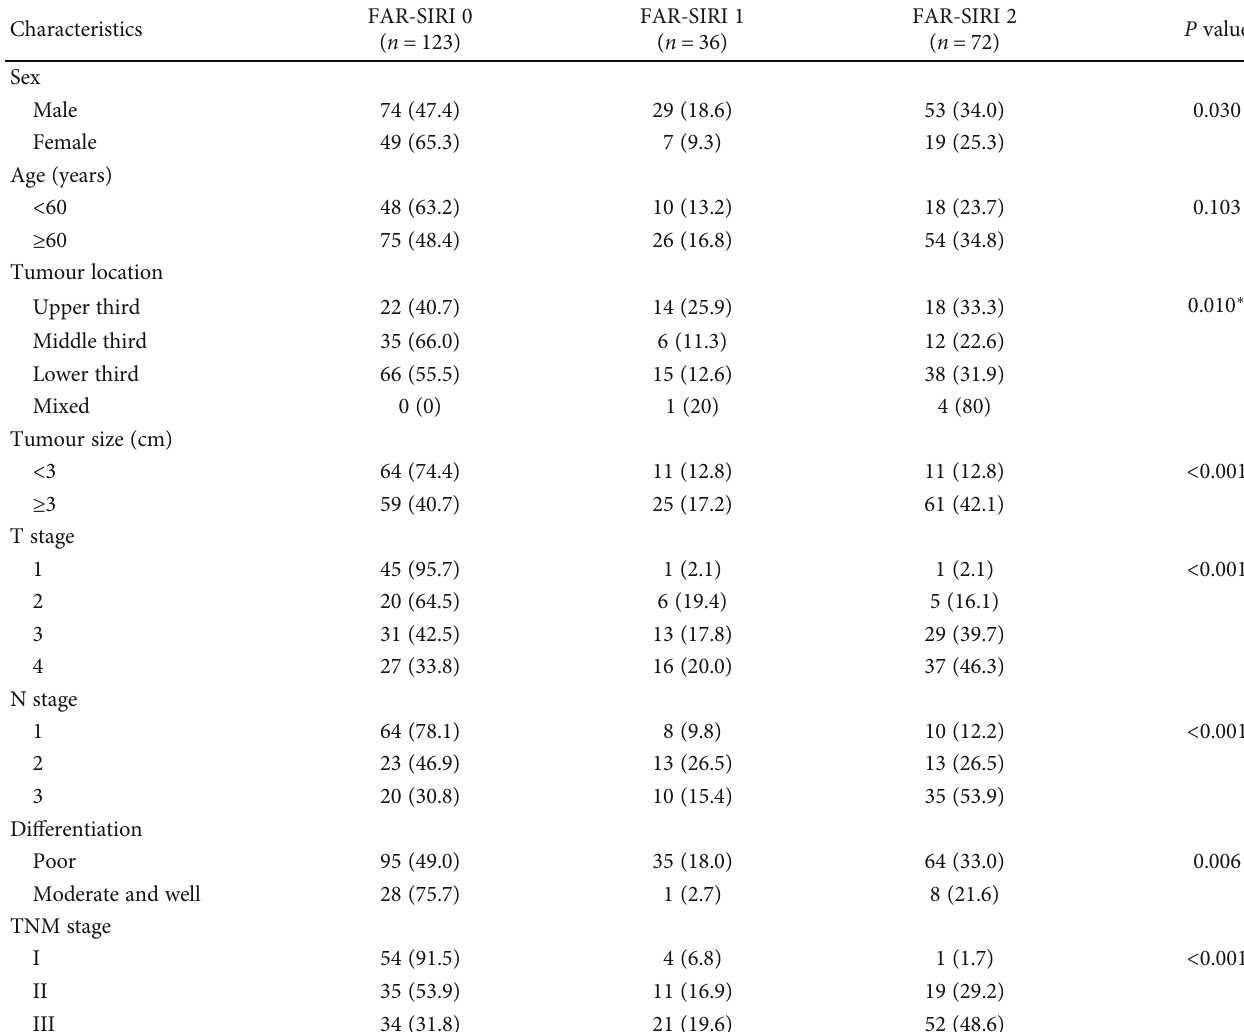
Table 2: The clinicopathological characteristics strati fi ed by the FAR-SIRI